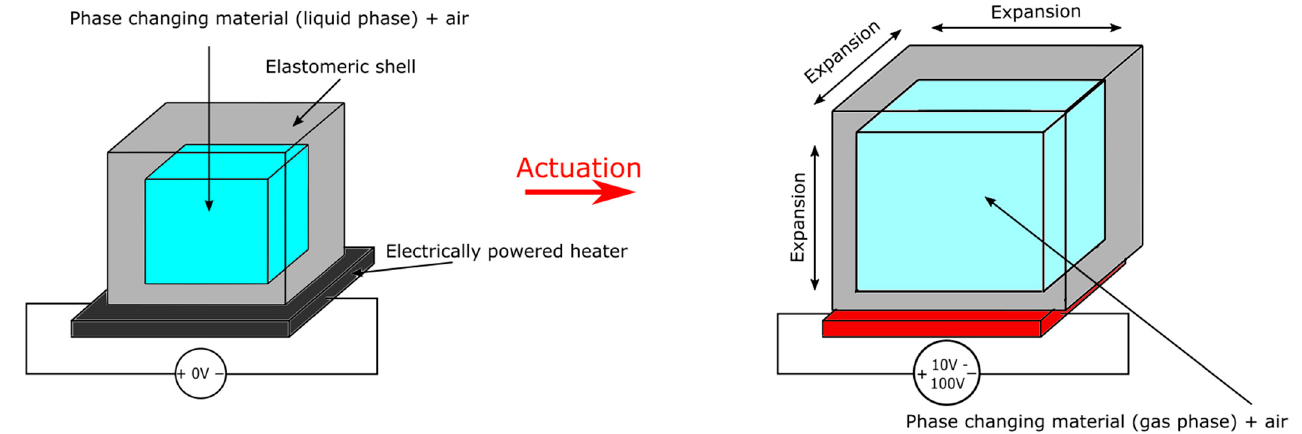
Figure 8. The actuation scheme of an elastomeric pouch actuator. The external resistive heater is required with a powering voltage typically between 10 V–100 V. Heating above the phase changing material’s boiling point will cause vaporization. The increased gas pressure will cause volumetric expansion of the